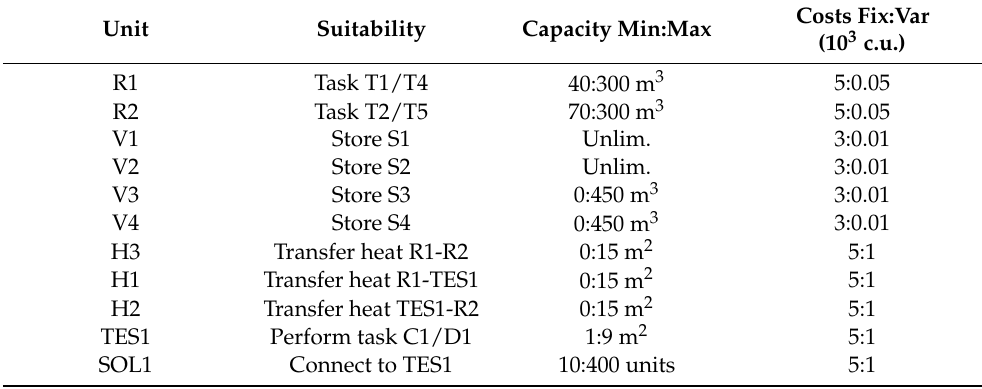
Table 2. Unit characteristics of Example I.